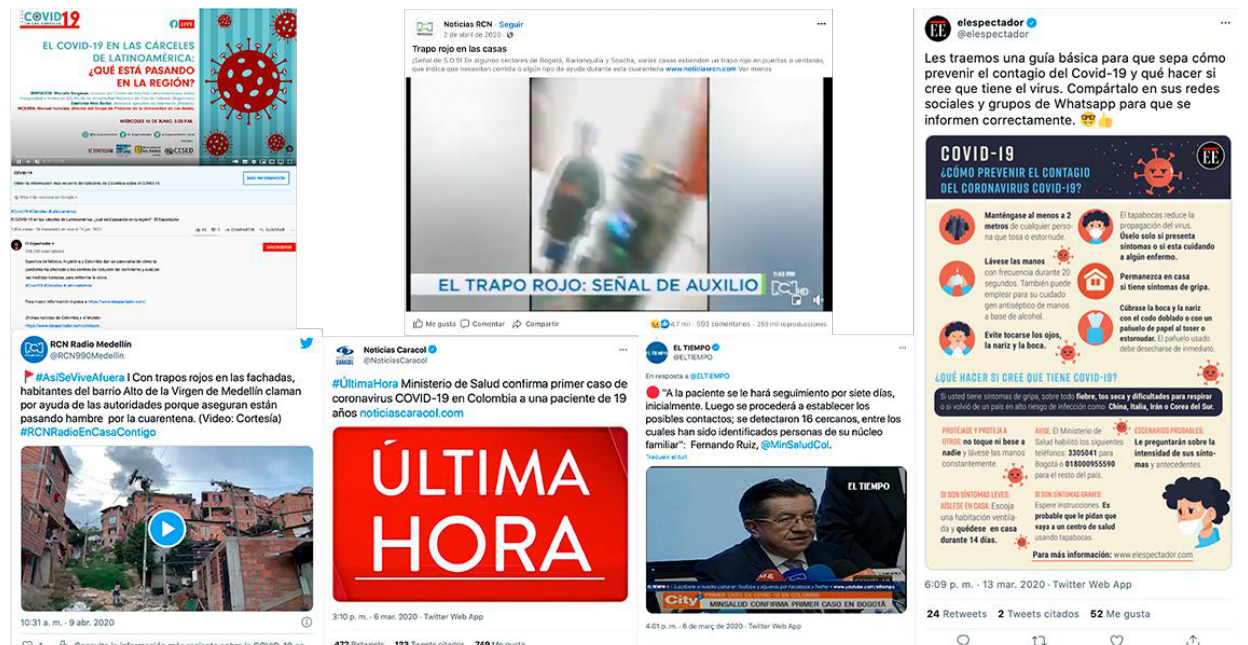
Figure 5. Examples of messages on social networks. Prepared by the author with images taken from social networks.